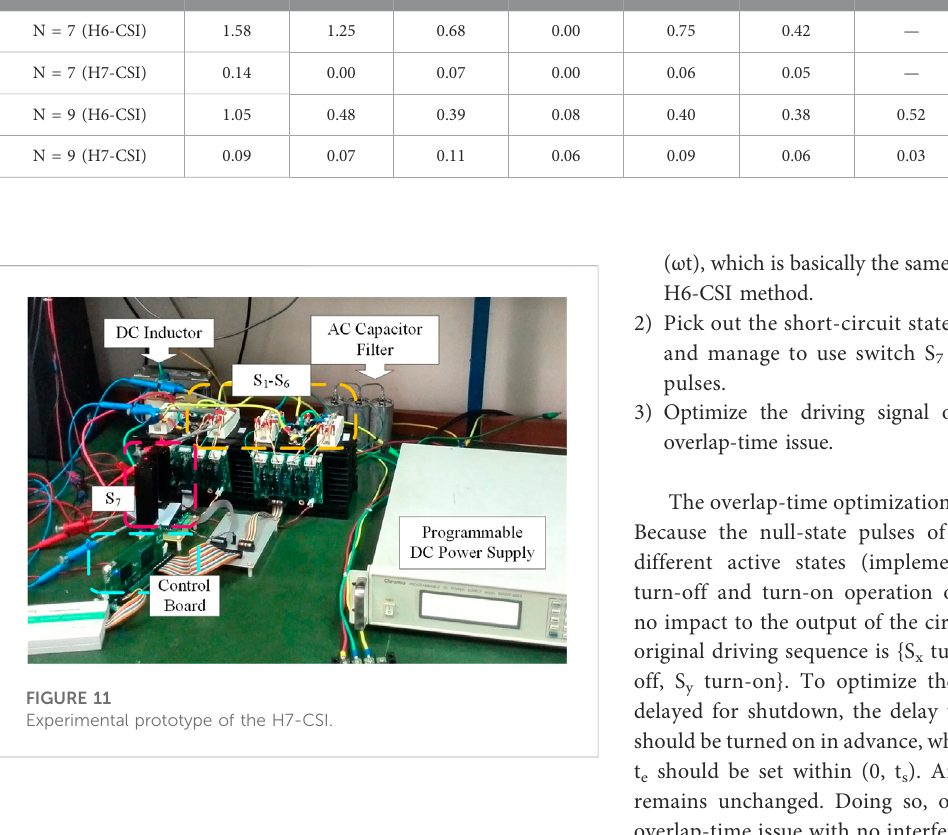
TABLE 4 Experimental parameters. Parameter